Question: What type of chart is this?
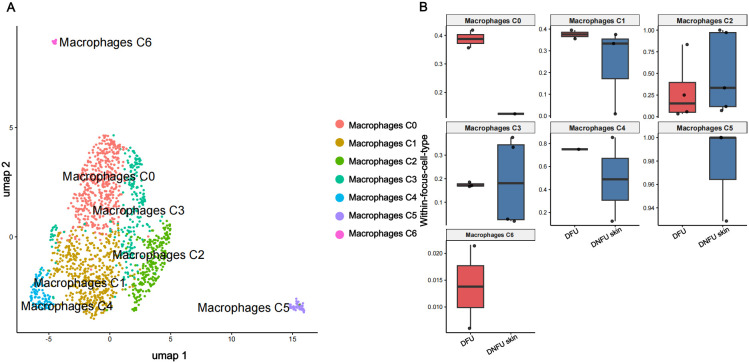
Answer: scatter